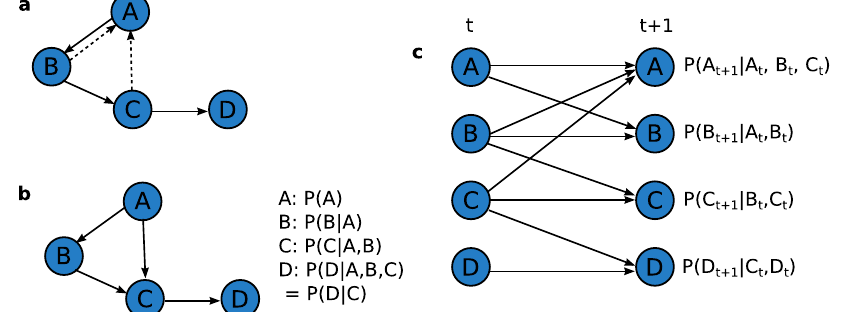
Figure 1. Example of Static and Dynamic Bayesian Network structures. ( a ) Shows a “true” network of dependencies between four example nodes, which contains two directed cycles: → → A B A and → → → A B C A . Since this is not a DAG, we cannot capture the true structure of this network with an SBN. Removal of the dashed edges would create a valid DAG. ( b ) Shows a valid DAG that could be used as an SBN structure for these nodes, created by removing the → B A link and flipping the direction of the → C A link. The local probability distributions that define the SBN are shown to the right. ( c ) Shows the true network “unfolded” in time into a DBN structure. This unfolded structure captures all dependencies between nodes in the true network, but is a valid DAG. Nodes at time t are on the left, nodes at time t + 1 on the right. Self-dependencies have been included to capture autocorrelation. Local probability distributions that define the DBN are given to the right of each